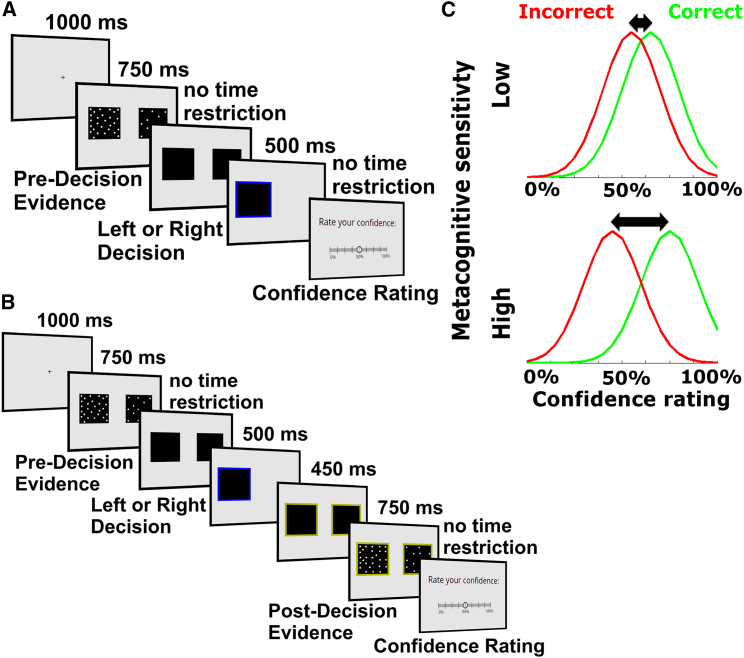
Behavioral Tasks(A) Confidence task (task 1): Participants were asked to judge which of two patches contained a greater number of flickering dots before rating their confidence in each decision. Task difficulty was determined by a fixed difference in dot number between the patches and was individually adjusted in an initial calibration phase to target approximately 71% correct performance.(B) Post-decision evidence integration task (task 2): Participants performed the same perceptual decision as in part (A), but after each decision, they were presented again with a new sample of flickering dots before rating their confidence. In half of trials, participants received the same evidence strength post-decision as pre-decision, while in the other half of trials, they received stronger post-decision evidence (pre-adjusted to a strength that led to 80% performance).(C) Metacognitive sensitivity is defined as the correspondence between task performance and confidence ratings—the extent to which participants rate higher confidence when correct and lower confidence when incorrect. Each graph shows a hypothetical probability distribution over confidence ratings for correct and incorrect trials, with the overlap between distributions determining metacognitive sensitivity. A small separation between these distributions indicates low metacognitive sensitivity (upper), while a large separation indicates high metacognitive sensitivity (lower).See also STAR Methods.